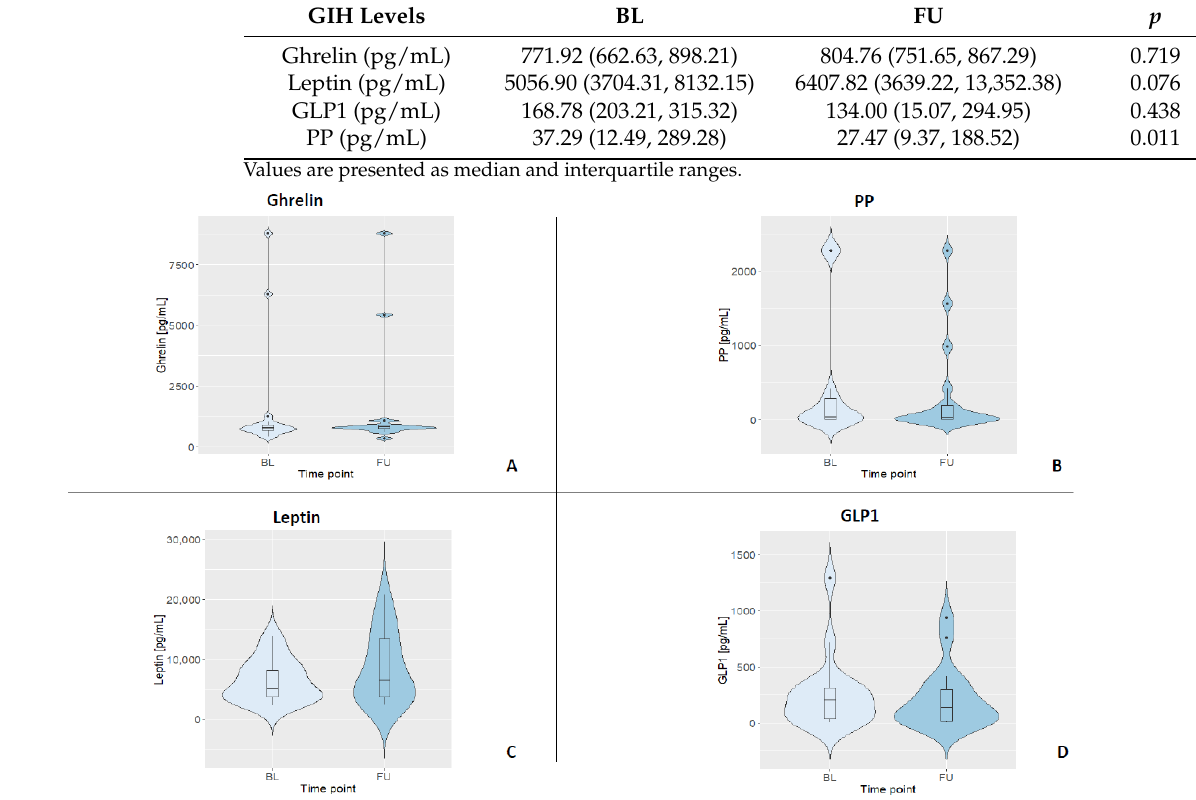
Figure 2. Violin plots displaying the kernel distribution of all GIH levels for both assessments (BL = baseline, FU = follow-up). Box plots include the first through third quartiles, with the horizontal line representing the median. Black dots represent outliers. ( A ) Distribution of ghrelin. ( B ) Distribution of PP. ( C ) Distribution of leptin. ( D ) Distribution of